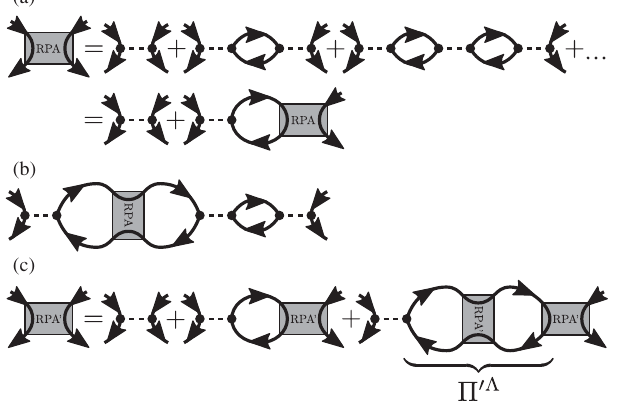
FIG. 23. RPA-type approximations for the two-particle vertex in the large- S limit. Dashed lines are the bare interactions J ij , and lines with an arrow are the bare and Λ -regularized pseudofermion propagators from Eq. (6). Gray boxes denote the two-particle vertex in different approximations. (a) Plain RPA scheme sum- ming up diagrammatic terms of the order of 1 =S . (b) An example of a contribution to the two-particle vertex of the order of ð 1 =S Þ 2 . (c) Improved RPA scheme, RPA 0 , regularizing the divergence of the two-particle vertex occurring in plain RPA. See the text for